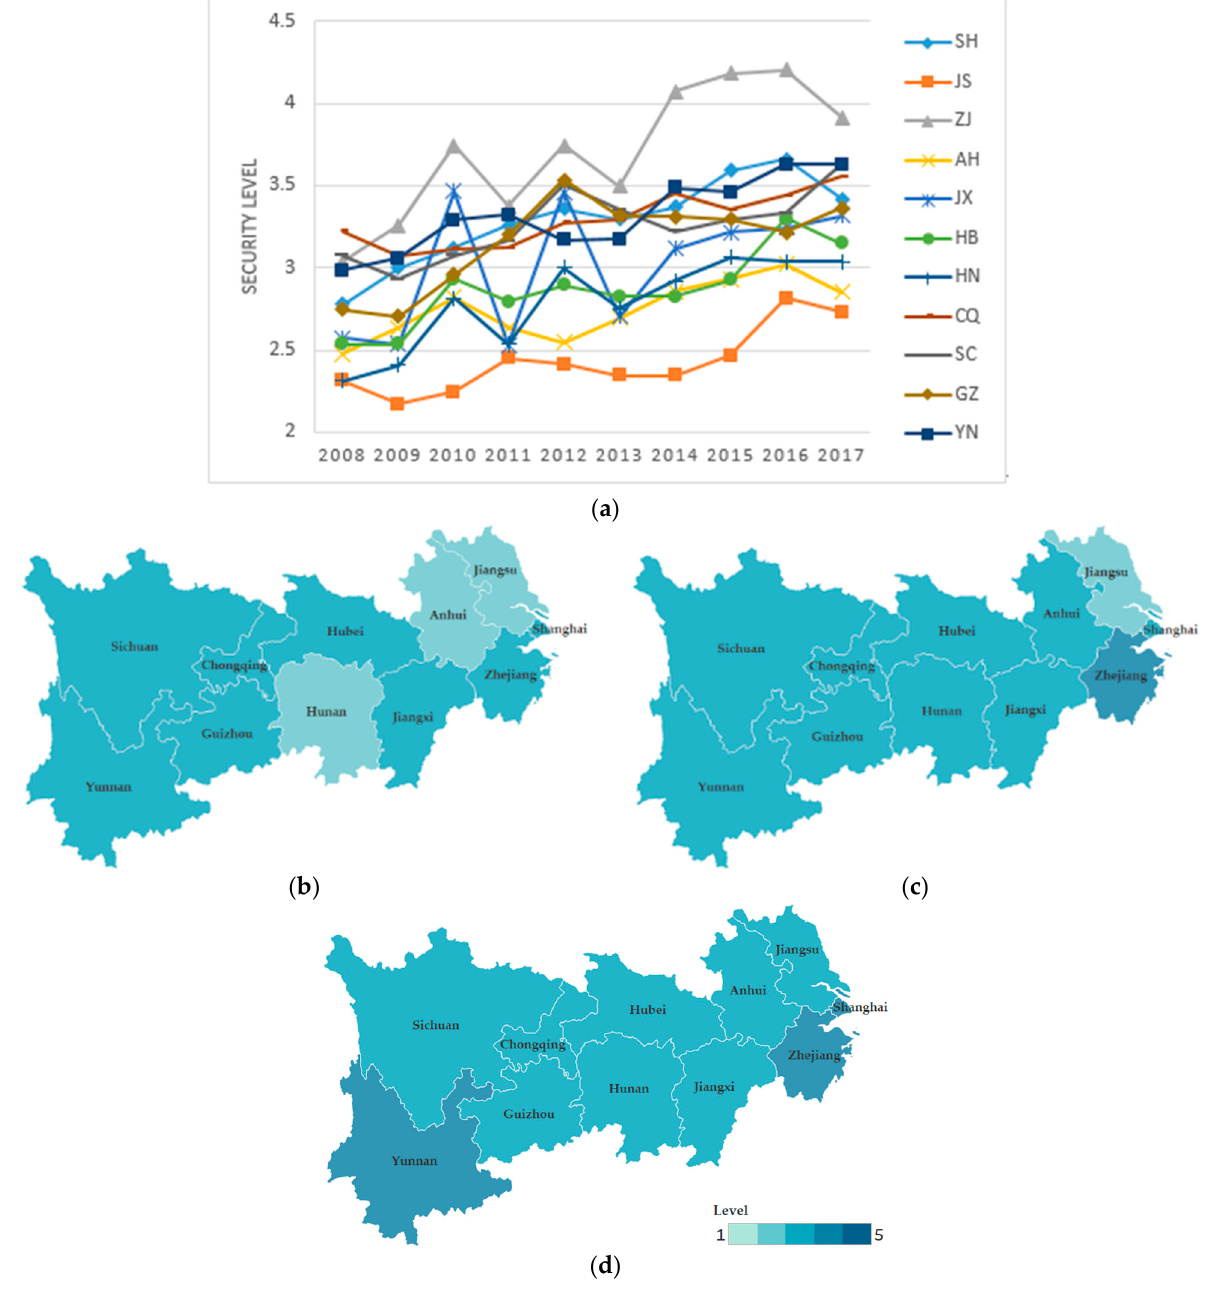
Figure 5. Water resources subsystem evaluation results: ( a ) Trend graph of water subsystem security of each province (municipality) in the Yangtze River Economic Belt during 2008–2017; ( b ) Distribution of water resources security in 2008; ( c ) Distribution of water resources security in 2012; ( d ) Distribution of water resources security in 2016.